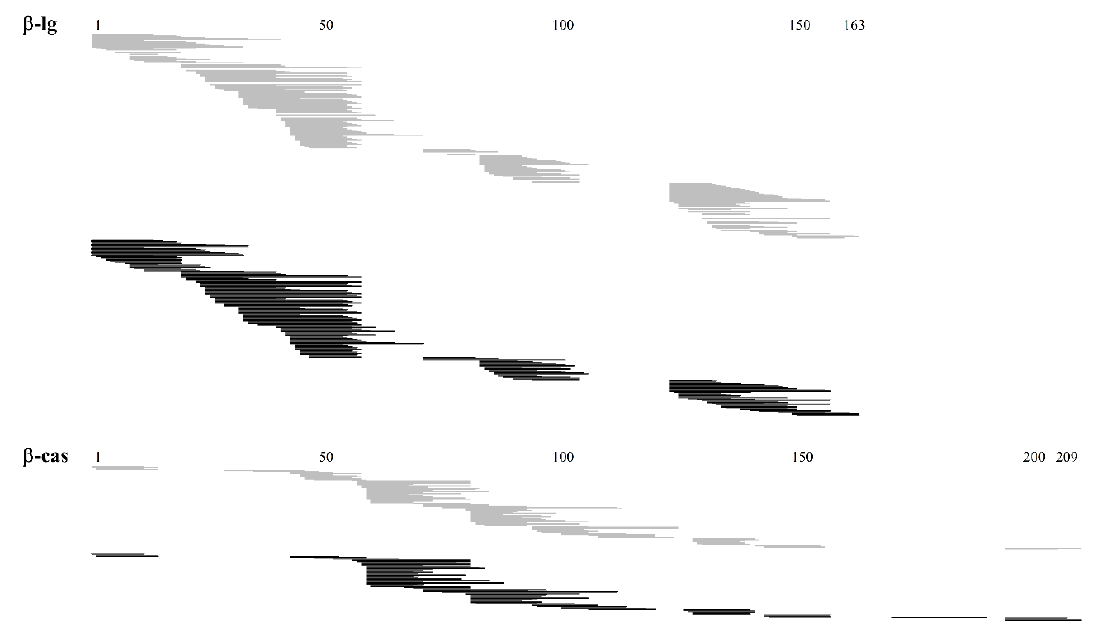
Figure 4. Peptides released from undigested (WPH) and previously intestinal digested (ID) whey protein hydrolysate identified by NanoLC-MS / MS in the basolateral compartment of the UC. Peptides found in the WPH and ID samples are represented by grey and black lines, respectively. Numbers represent the amino acid chain of each protein.